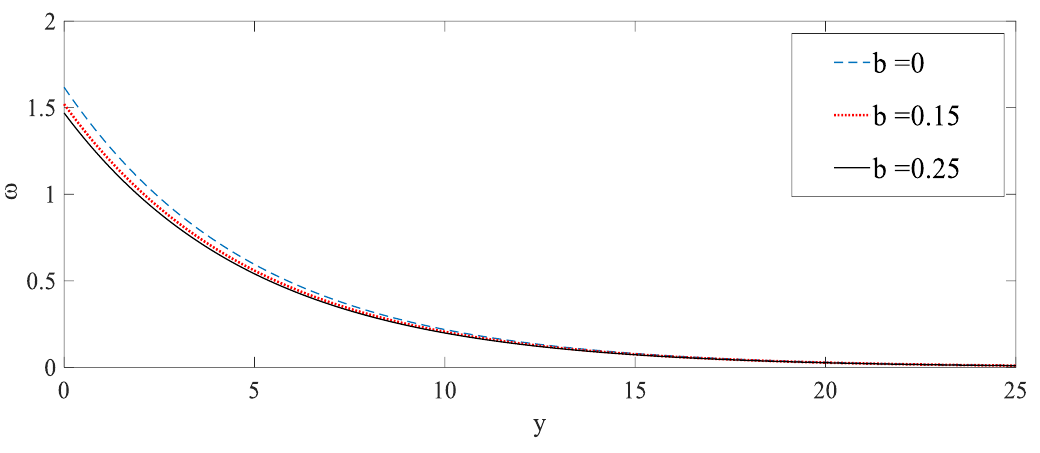
Figure 3. Angular velocity profile against displacement variable y for Nr=0.1, Pr=5, M=2, Sc=2, Kr=0.5, Du=0.5, Q=0.2, Q 1 =0.3, e=0.001, eta(η) =0.2, n=0.1, Kp=0.3, Gr=5, n 1 =0.2, h=0.4, Gm=0.3 at t=0.5